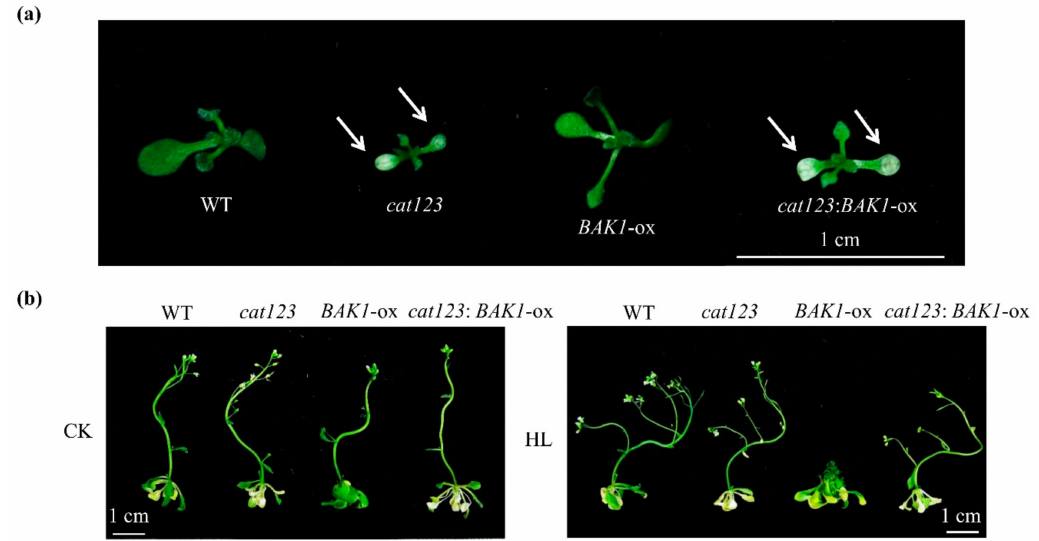
Figure 6. Knockout of catalase genes abolishes BAK1 overexpression-mediated suppression on plant growth-promoted by high light. ( a ) Seedlings of the cat123 and cat123:BAK1-ox triple mutants generated by CRISPR-Cas9. Arabidopsis seedlings with di ff erent genetic backgrounds were grown for 10 days before being photographed. The arrow shows leaf bleaching. The experiments were repeated three times with similar results. ( b ) Knockout of catalase genes in BAK1-ox plants restored growth promoted by high light. Seedlings were grown for 8 days on 1 / 2 MS medium and then treated with high light (400 µ mol · m − 2 s − 1 ) for 22 days before being photographed. Scale bars = 1 cm. The experiments were repeated three times with similar